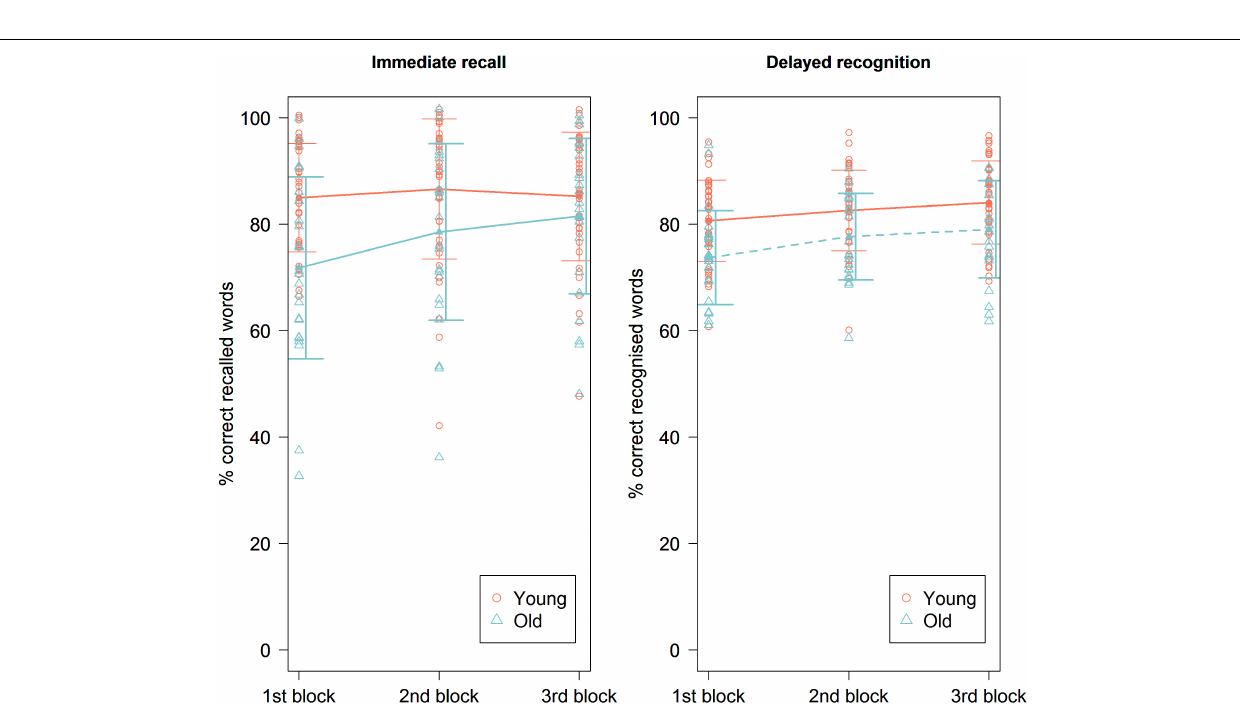
FIGURE 3 | Immediate recall (left) and delayed recognition (right) accuracy scores in percentage during the three blocks of the experimental session for the young and the old group. A significant effect of order was seen on immediate recall scores in the old age group and on delayed recognition scores in both age groups, showing significantly higher scores toward the end of the paradigm. Line plots represent mean scores. Error bars represent standard